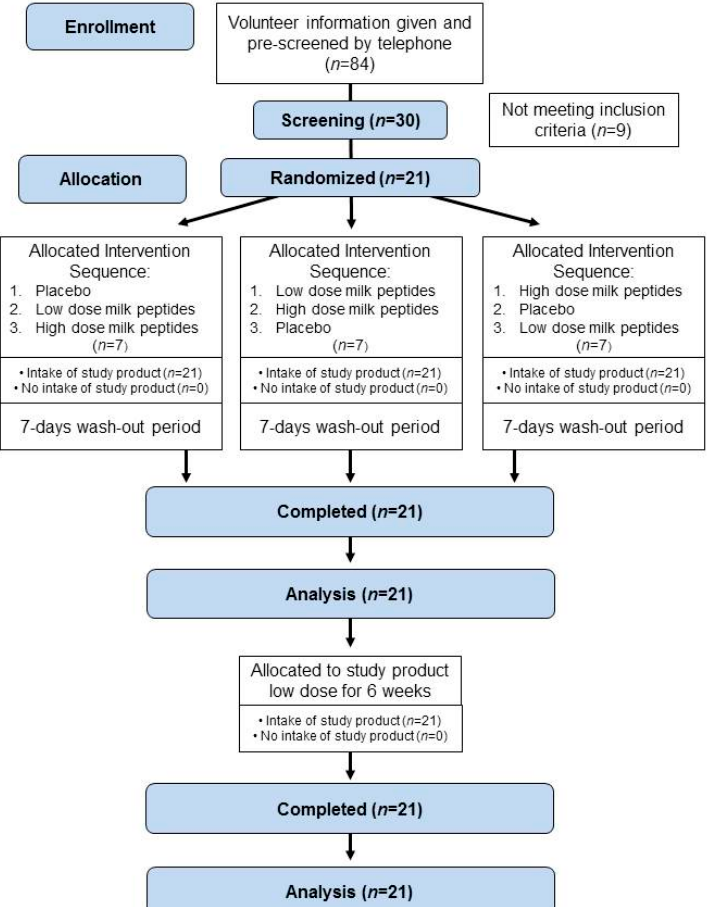
Figure 1. Subject recruitment flow chart.